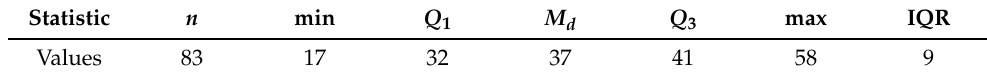
Table 9. Descriptive statistics for the COVID-19 data set of Saudi Arabia.